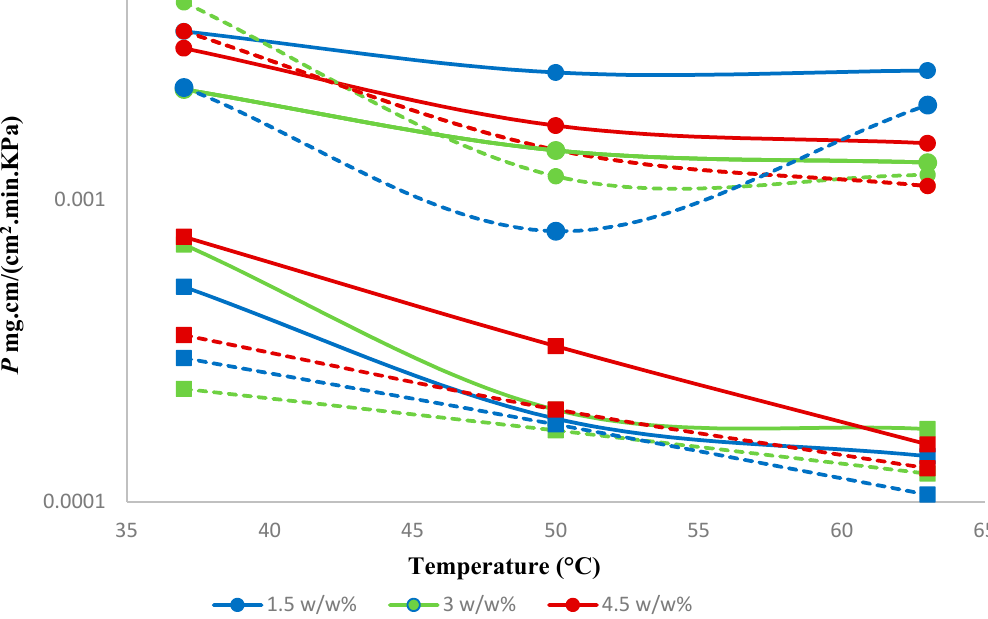
Figure 10. Effect of feed concentration on the permeability of 1-butanol and water. Solid lines represent a hybrid PTMSP membrane, and dotted lines represent a neat PTMSP membrane. ( ● —1-butanol and ■ —water). Data for pure PTMSP were taken from the literature [26].